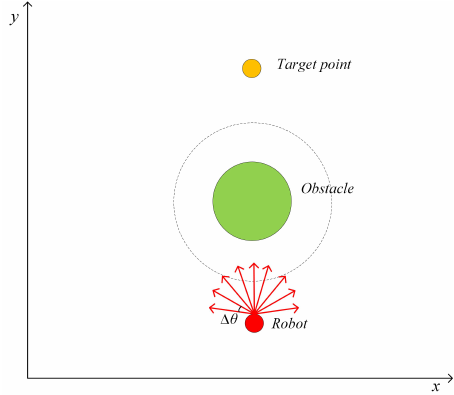
Figure 3. Robot trajectories simulated by a dynamic window approach